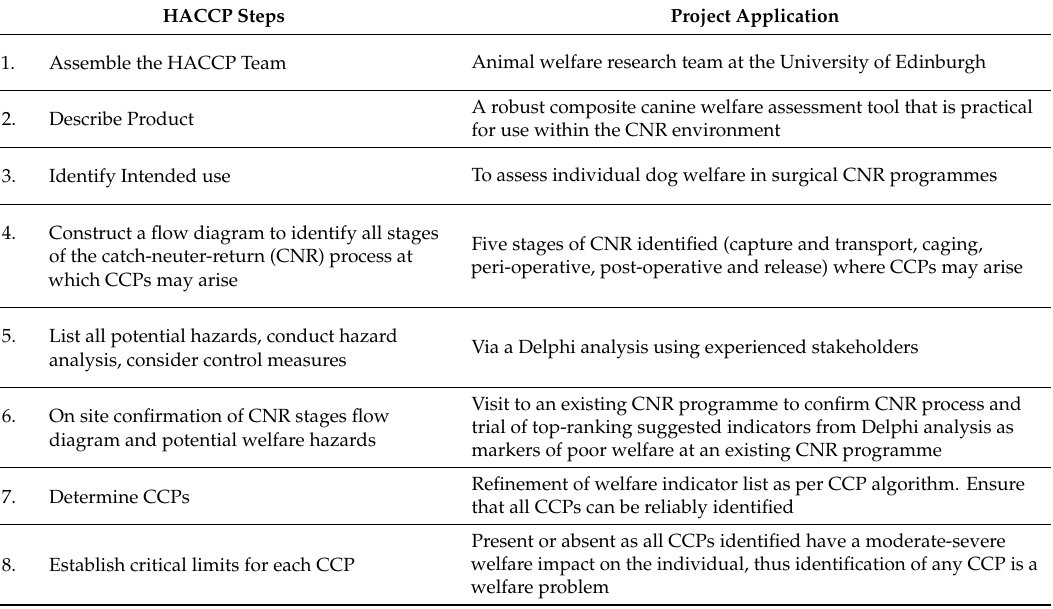
Table 1. The Hazard Analysis and Critical Control Point (HACCP) process as applied to this